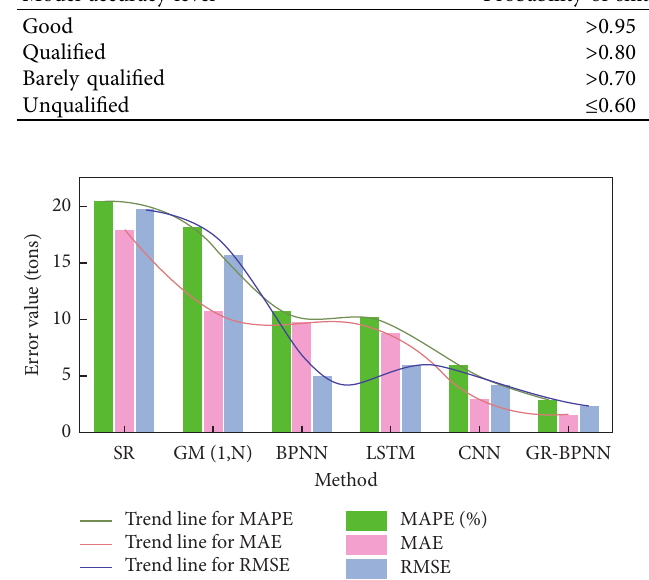
Figure 5: Accuracy comparison between different models. SR: stepwise regression; GM (1, N): grey GM (1, N) model; BPNN: backpropagation neural network; LSTM: long short-term memory; CNN: convolutional neural network; GR-BPNN: grey back propagation neural